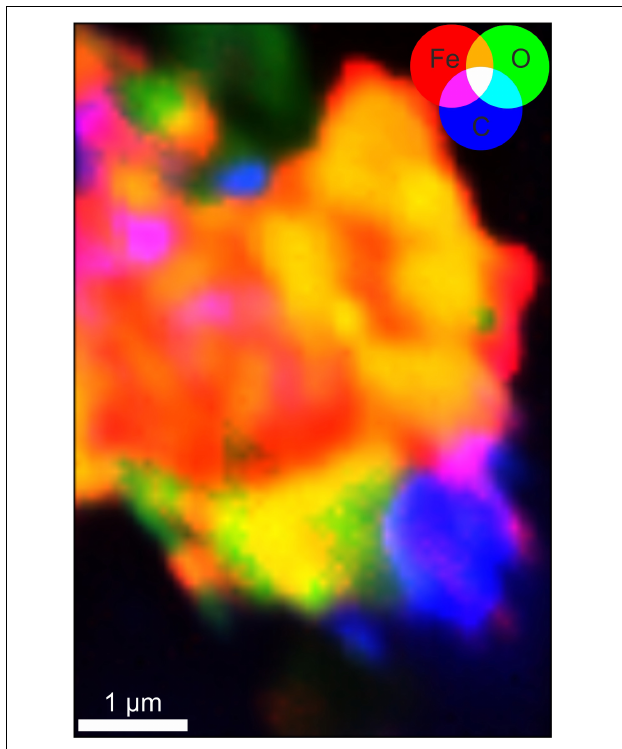
FIGURE 6 | Synchrotron µ XRF map of the same sample shown in Figure 5D , for Fe (red), O (green), and C (blue). White scale bars represent 1 µ m. The color scale indicates intensity of the µ XRF signal for each